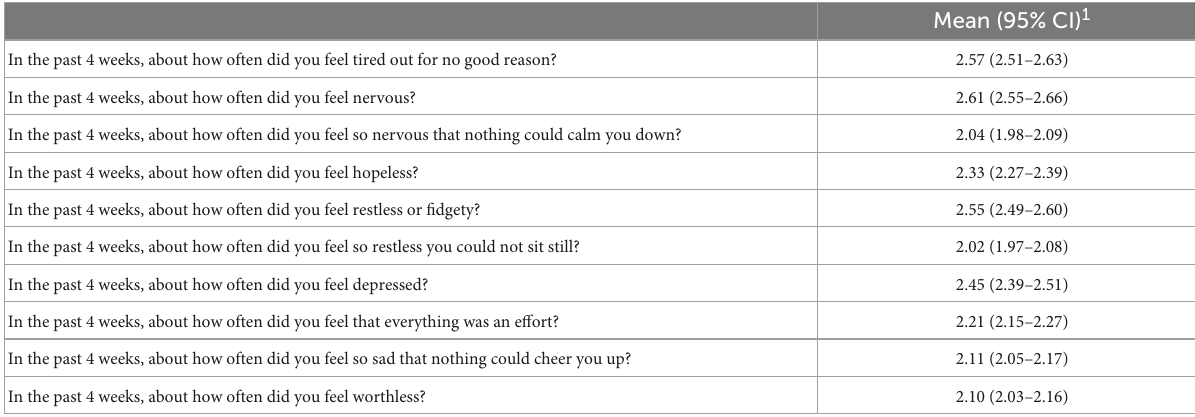
TABLE 5 The distribution of answers on the distress